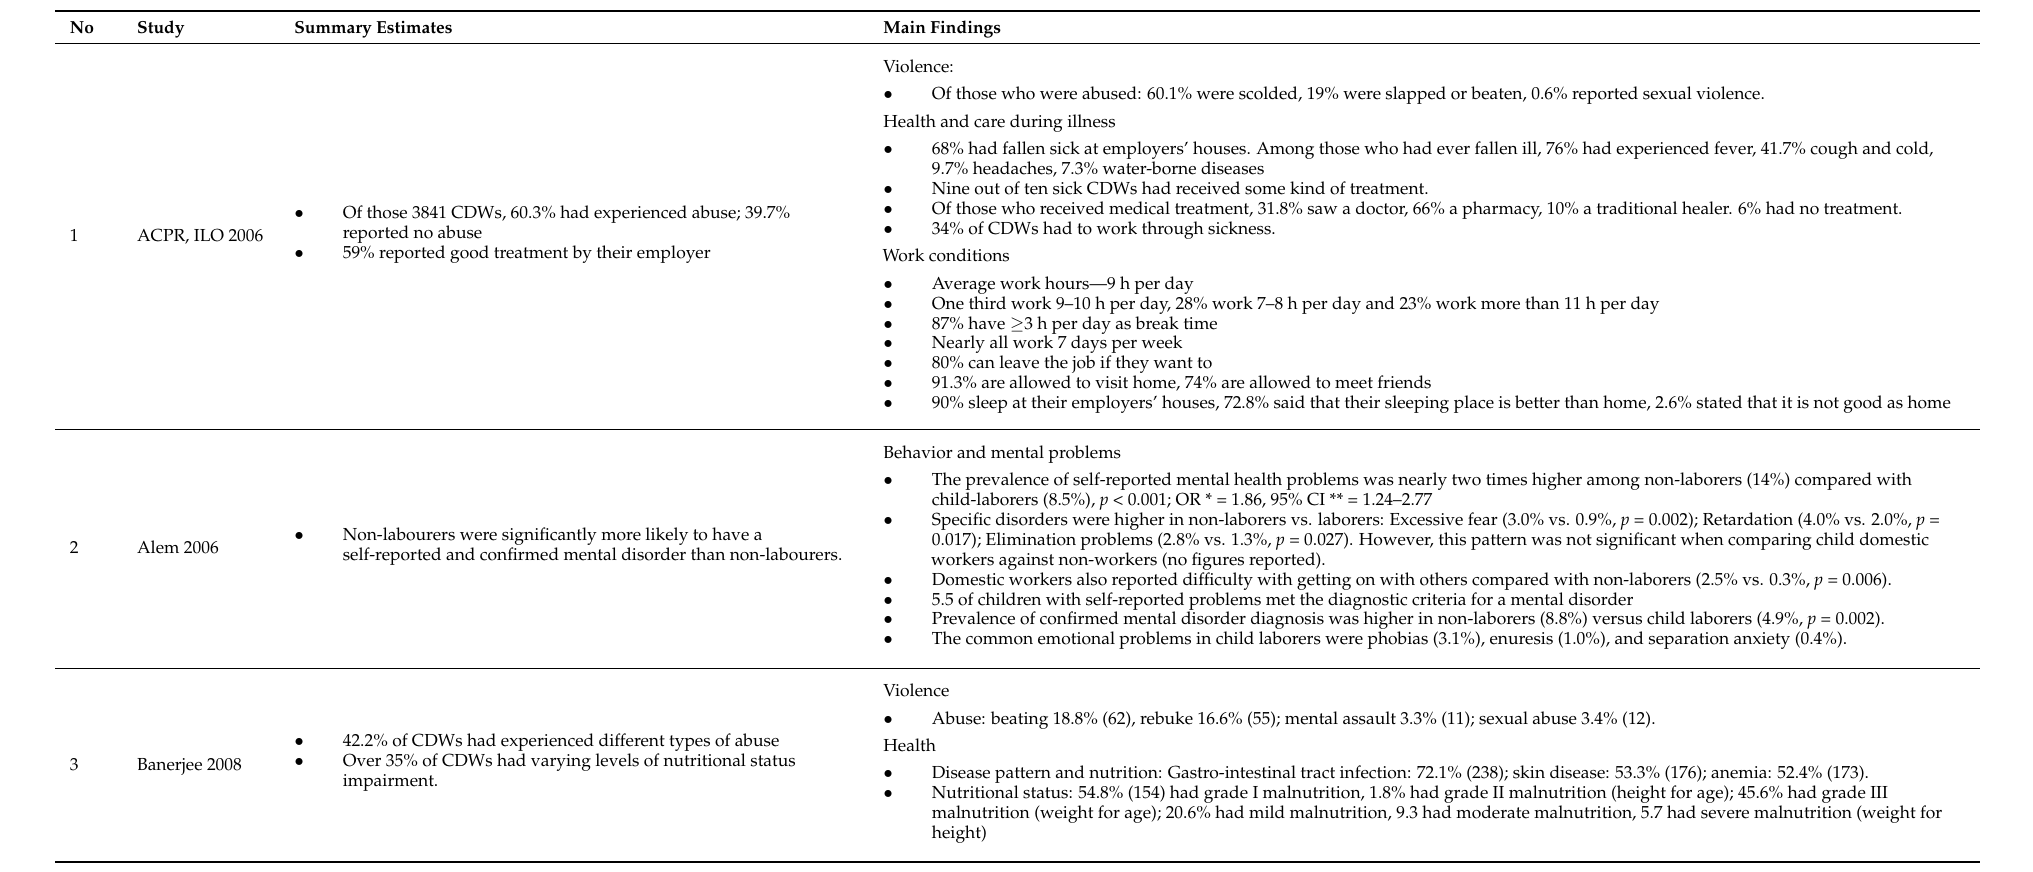
Table 2. Summary description of main findings from the studies that reported violence and/or health outcomes among child domestic workers ( n =